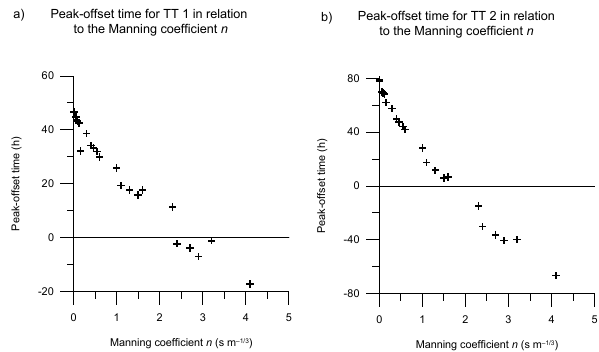
Figure 5. Difference between peak concentration times vs. the Manning n value for scenario 1. High n values correspond to high conduit volumes and high cross sectional areas at the spring (a) for tracer test 1 and (b) for tracer test